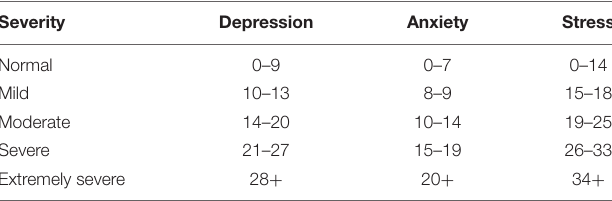
TABLE 1 | DASS severity rating (multiply summed score by × 2) (Henry and Crawford,